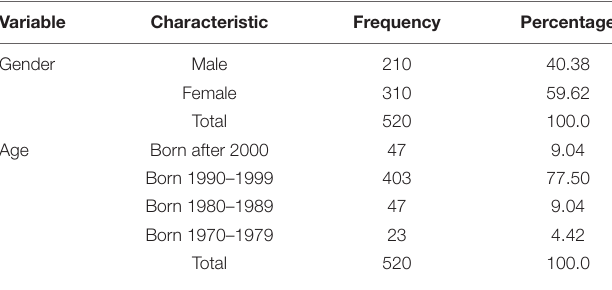
TABLE 1 | Demographic profile of the